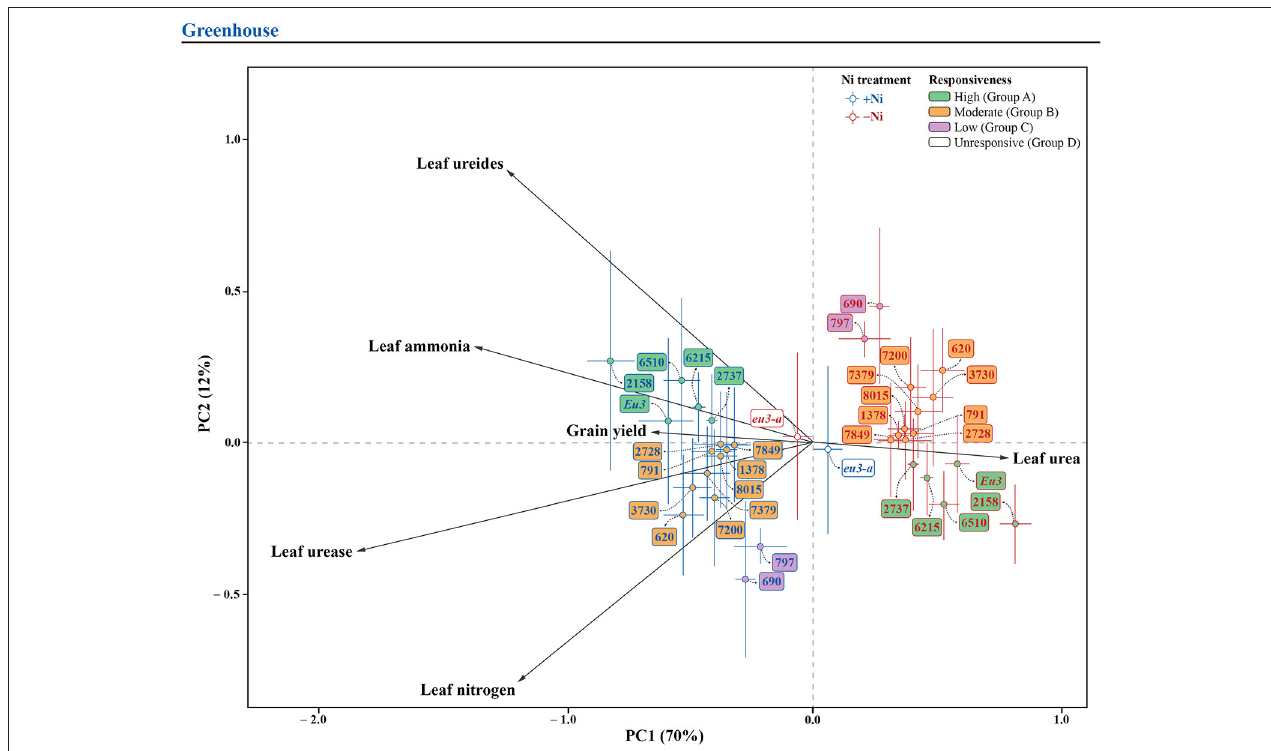
FIGURE 4 | Biplot of partial principal components analysis of the variables related to N metabolism, leaf N concentration and grain yield for 15 soybean genotypes and two near-isogenic lines (NILs, Eu3 and eu3-a), fertilized with 0.0mg of Ni kg − 1 ( − Ni) and 0.5mg of Ni kg − 1 ( + Ni), cultivated in greenhouse condition. In the figure, genotypes are divided into four groups according to responsiveness of N metabolism to Ni fertilization: Group A, high; B, moderate; C, low; and D, unresponsive.